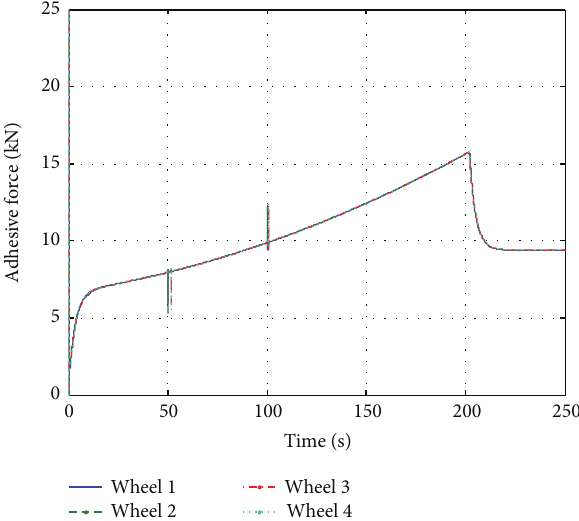
Figure 11: Adhesion force of each driving wheel.